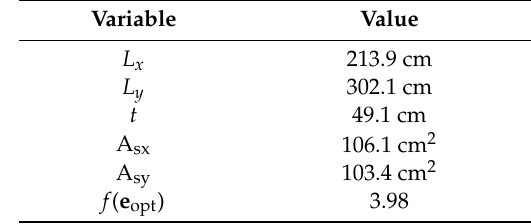
Table 8. Example 2: Optimum design vector and its objective value.